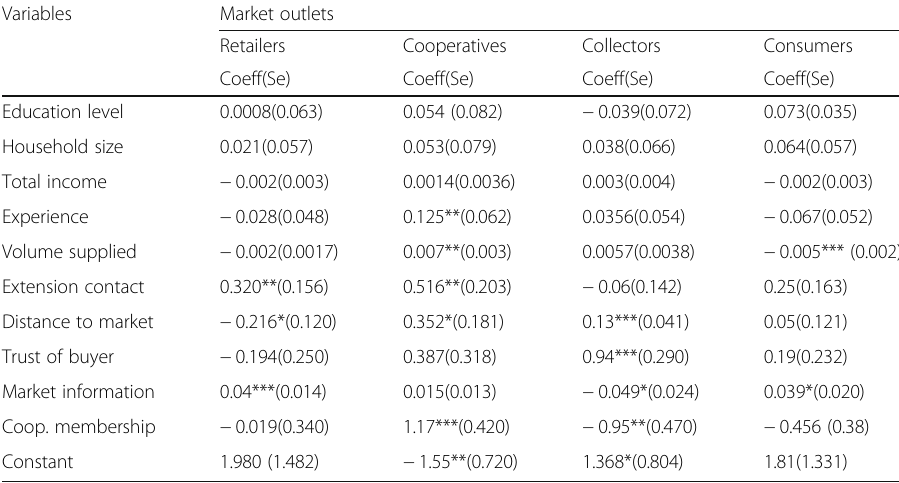
Table 5 Multivariate probit estimations for determinants of producers ’ outlet